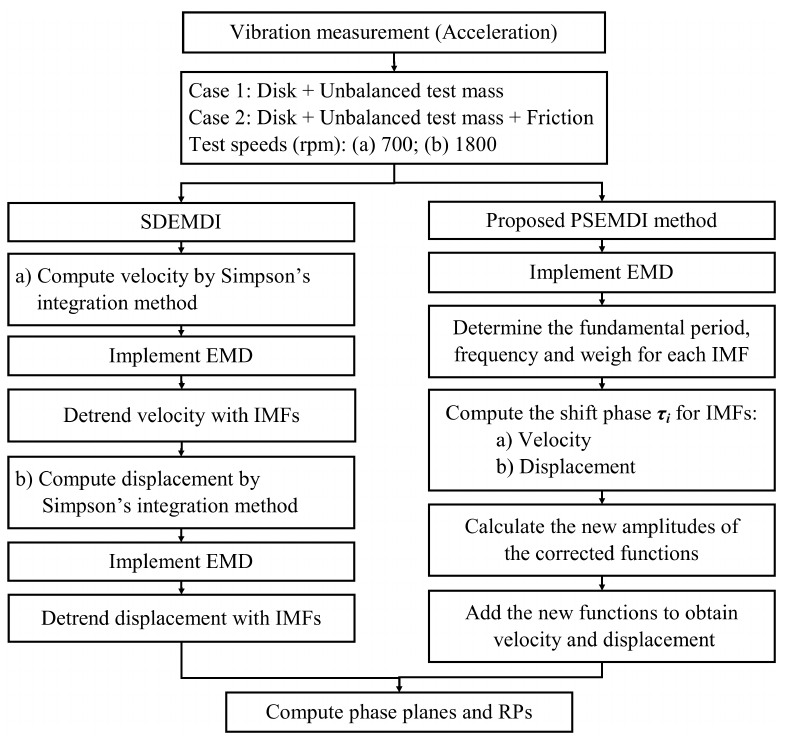
Figure 6. Block diagram of the proposed